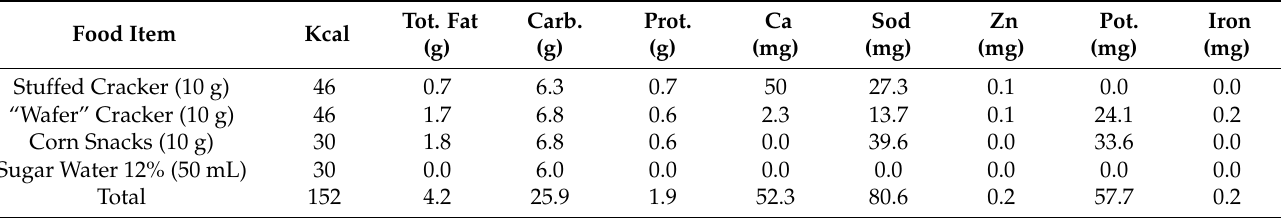
Table 1. Cafeteria diet composition for OVX/SM and OVX/SM/RIS